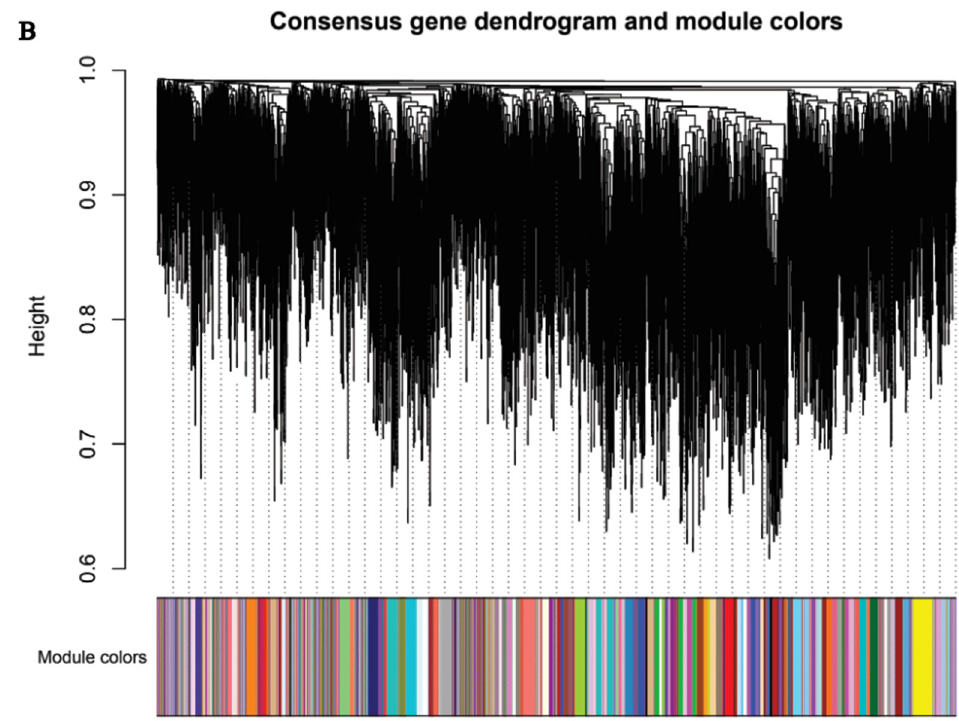
Figure 3. WGCNA analysis of the three datasets. ( A ) Analysis of network topology as a function of the soft-thresholding power for all three datasets. The panels show the scale-free fit index (top left), median connectivity (in degrees, top right), mean connectivity (in degrees, bottom left) and the maximum connectivity (in degrees, bottom right). ( B ) Clustering dendrogram of genes. Gene clustering tree (dendrogram) obtained by hierarchical clustering of adjacency-based dissimilarity. The coloured row below the dendrogram indicates module membership identified by the dynamic tree cut method and the assigned module colour.